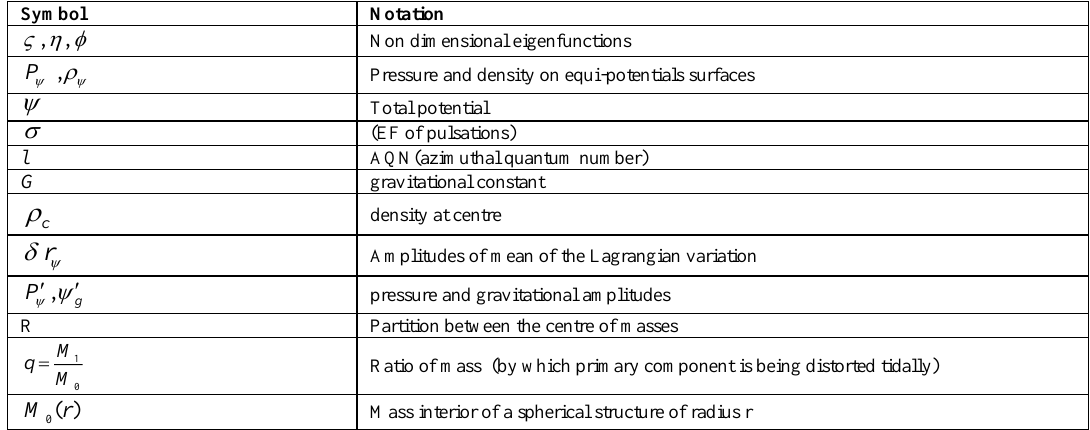
Table 1. Representations of